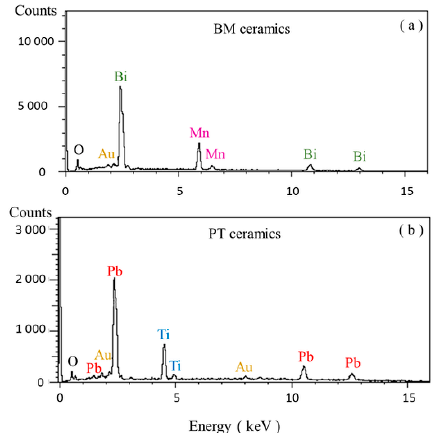
Figure 6. The survey spectra obtained for: ( a ) BM and ( b ) PT ceramics.